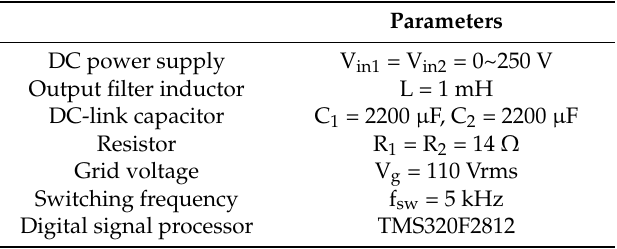
Figure 7. Experimental hardware setup and control block diagram of the prototype cascaded H-bridge multilevel inverter system. Table 1. System parameters of the prototype PV system.